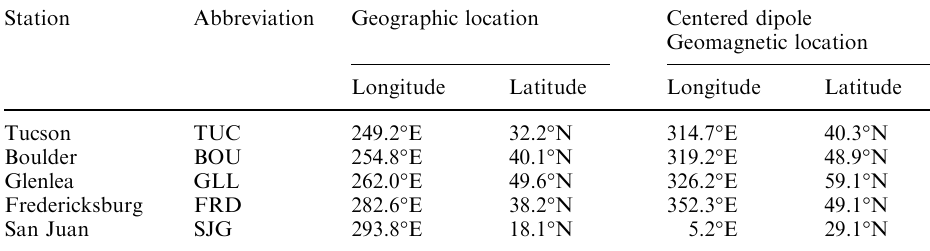
Table 2. The coordinates of the magnetic observatories referred to in this study